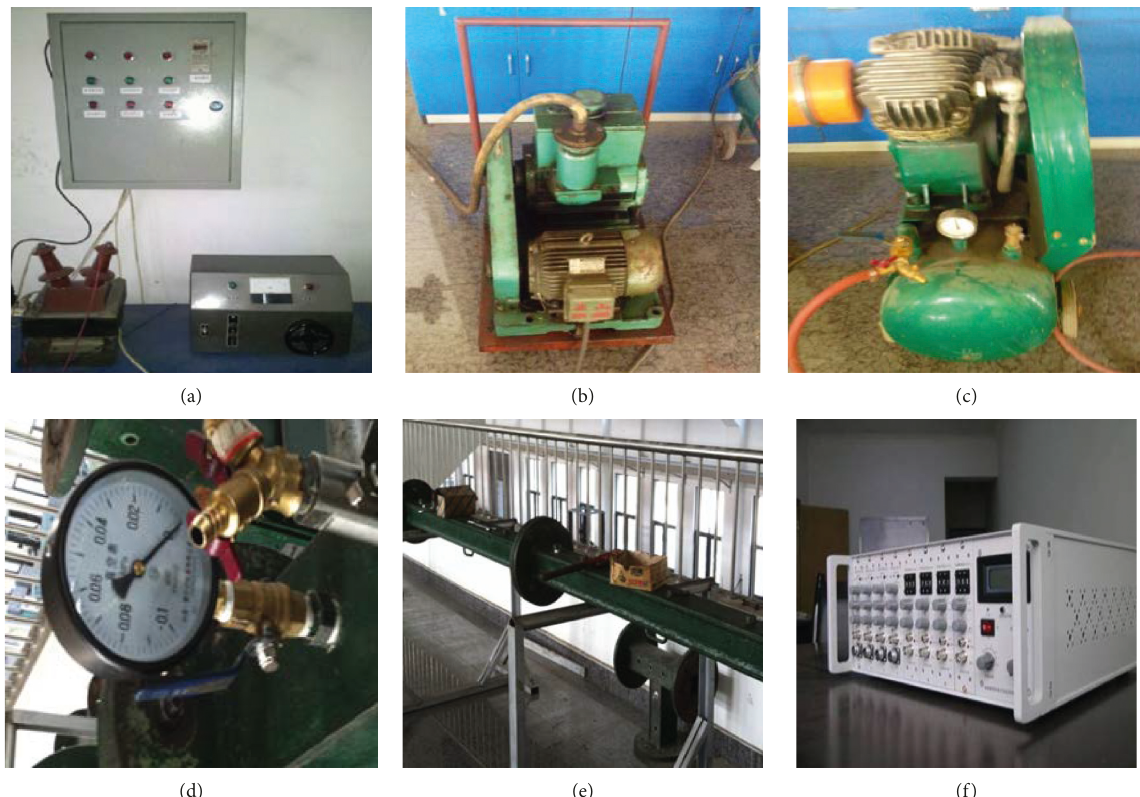
Figure 1: Gas explosion experiment system: (a) high energy ignition device; (b) air compressor; (c) vacuum pump; (d) vacuum meter; (e) gas explosion experimental pipe; (f) analysis system of dynamic data.